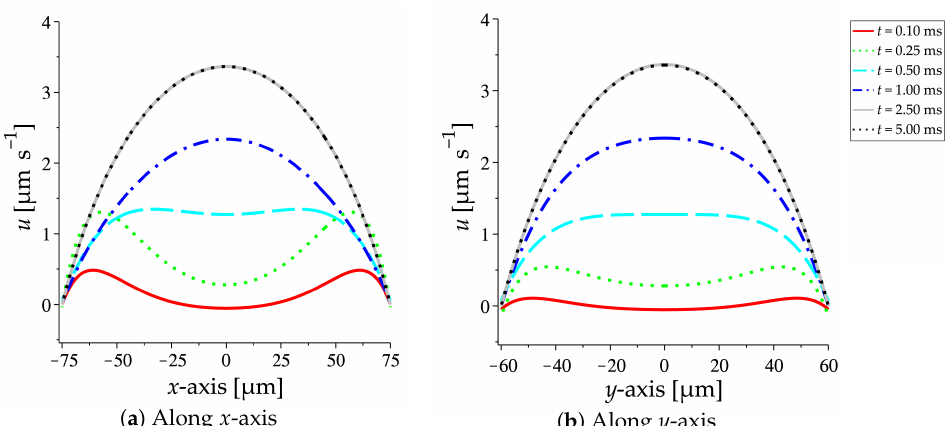
Figure 3. Variation of the velocity profiles of transient electroosmotic flow on time: ( a ) Along x -axis; ( b ) Along y